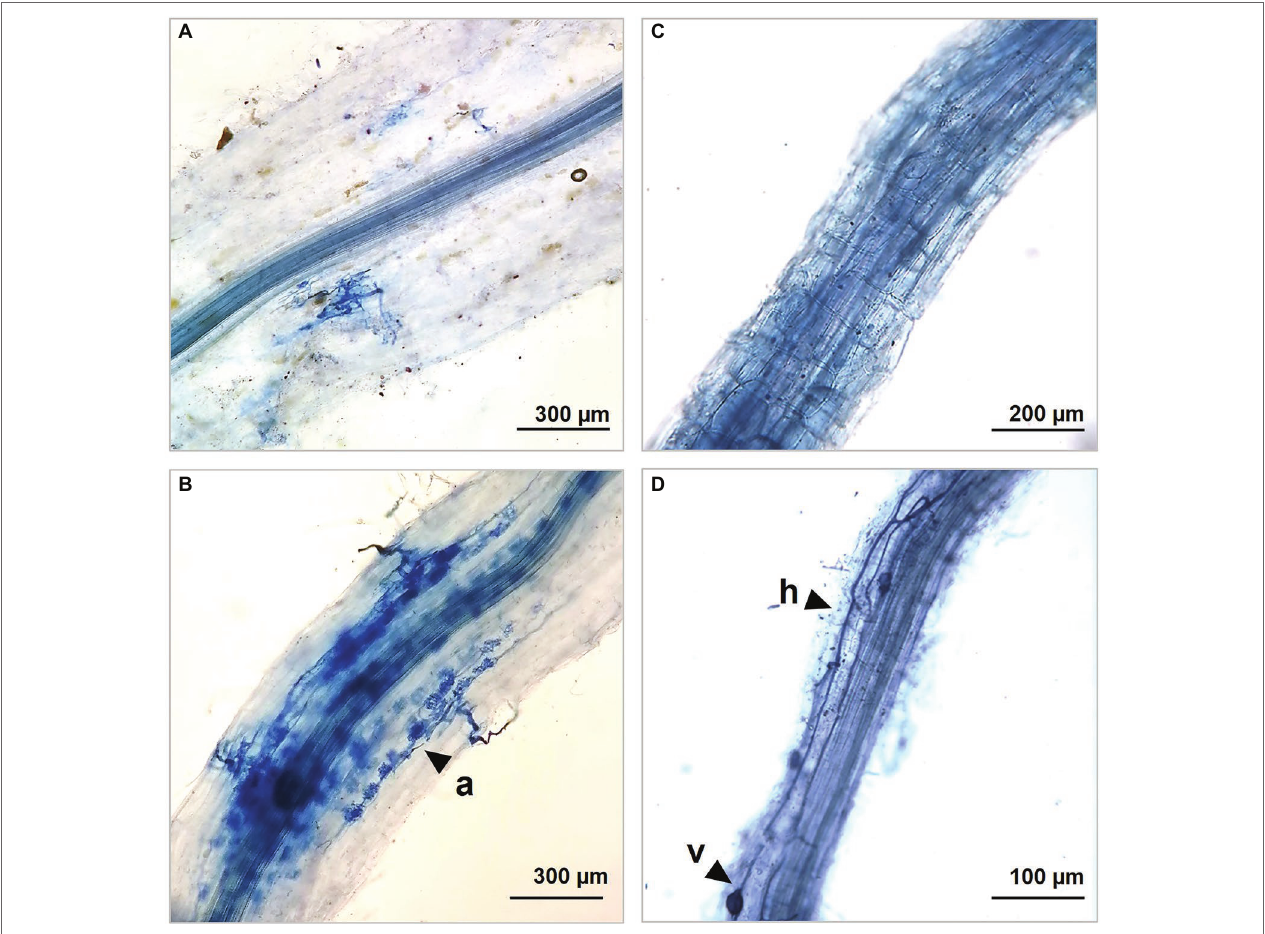
FIGURE 2 | Optic microscopic captions showing different colonization rate in our control A4R1 (A,C) and in treated samples A2R3 (B,D) at the end of the experiment. R3 treatment induces the development of a wide net of hyphes (h), arbuscules (a), and vescicules (v) that colonize fine S. arundinaceus roots developing mutual symbiosis for nutrient exchange between plant and mycorrhizal